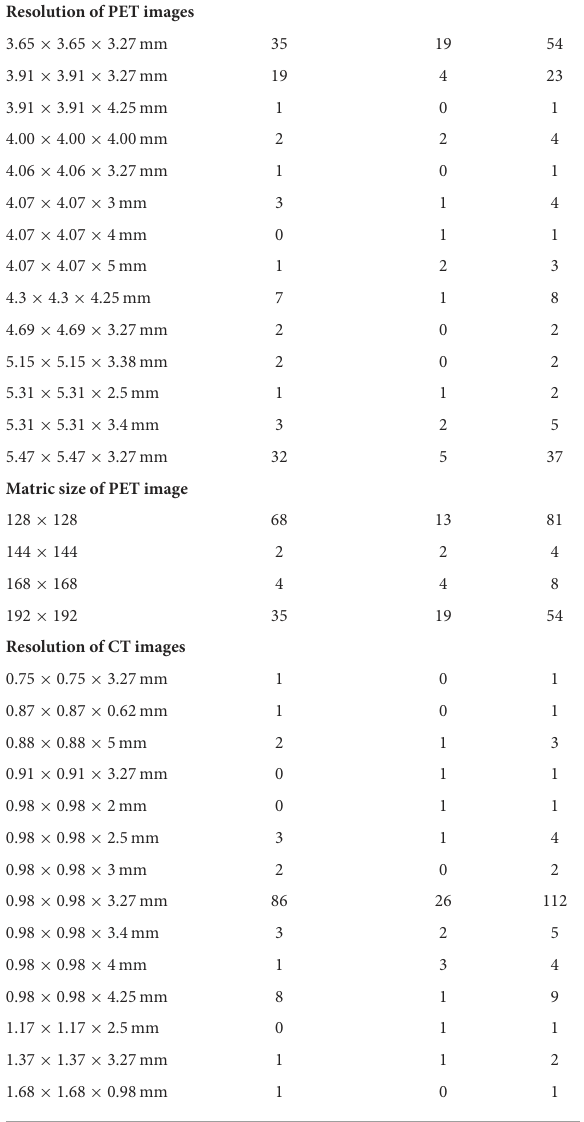
TABLE 2 Characteristics of the